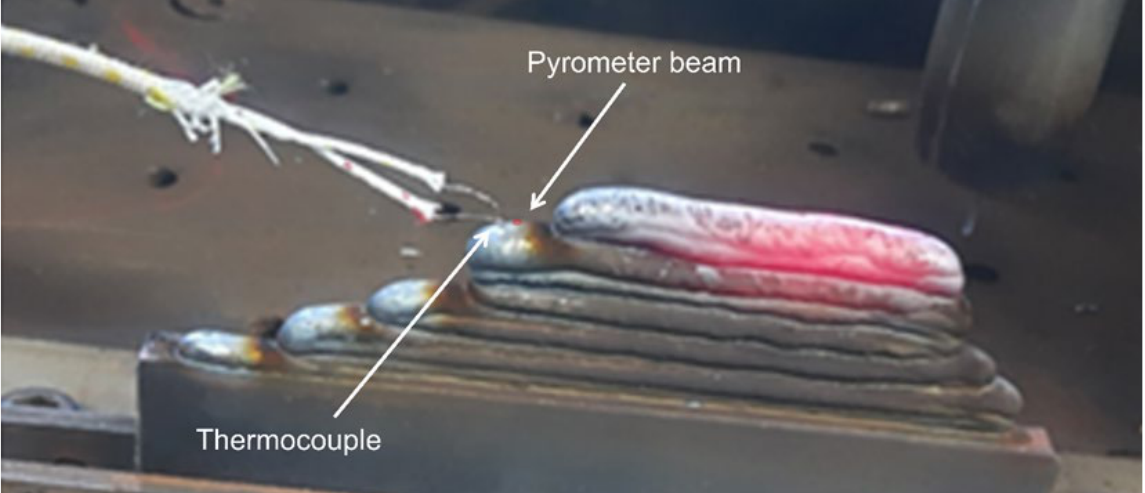
Figure 4. Experimental determination of the set emissivity coefficient (ε set ) for the upper pyrometer approach (the heating of the measuring point is a result of the layer deposited after the thermocouple has been fixed on a previous layer).